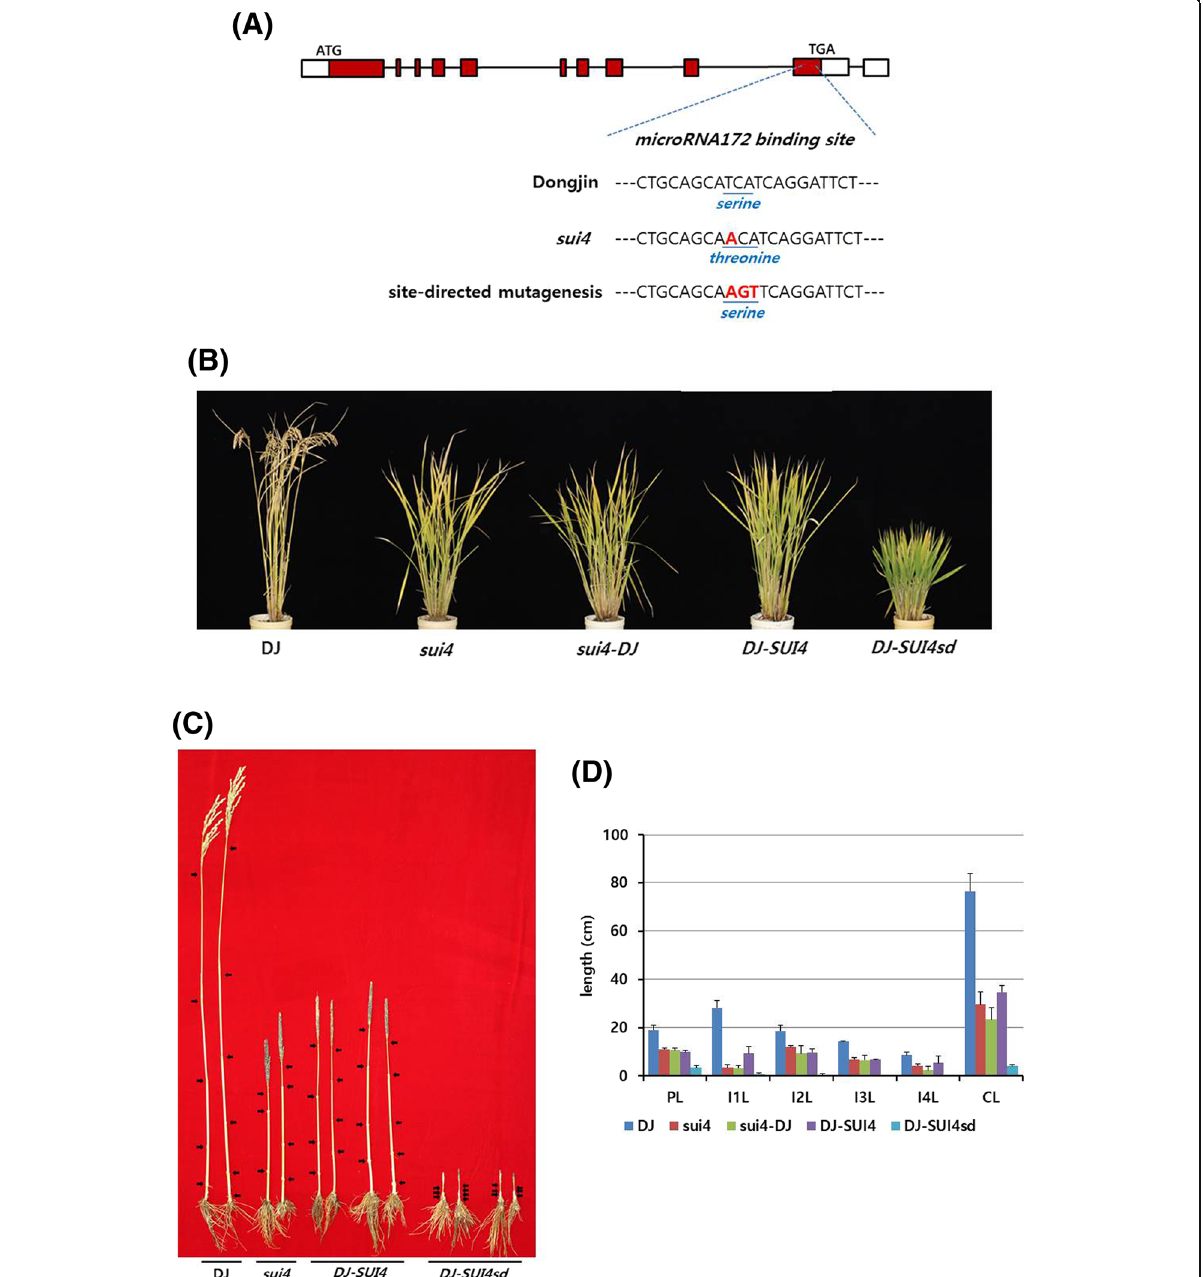
Fig. 4 Mutations in the Os07g0235800 gene and phenotypes of transgenic plants. ( a ) Structure of the SUI4/SNB gene and location of mutations. Empty boxes indicate 5 ′ and 3 ′ UTRs, filled boxes indicate CDS, and lines indicates introns. ( b ) Plant architecture at the maturing stage. DJ: Dongjin, sui4-DJ : transgenic line in which the SUI4 gene from a Dongjin plant was introduced into sui4 mutants, DJ-SUI4 : transgenic line in which the SUI4 gene from a sui4 mutant was introduced into Dongjin plants, DJ-SUI4sd : transgenic line in which the SUI4 gene, modified by site- directed mutagenesis as shown in ( a ), was introduced into Dongjin plants. ( c ) Culm structure. Arrows indicate locations of nodes. Two main culms from two plants are shown for each phenotype. Two independent transgenic lines are shown for DJ-SUI4 and DJ-SUI4sd. ( d ) Lengths of panicles, culms, and internodes. For DJ and sui4 , three main culms from three different plants were measured. For sui4 - DJ , DJ-SUI4 , and DJ-SUI4sd , six main culms from three to four independent transgenic lines were measured. PL: panicle length, I1L: first internode length, I2L: second internode length, I3L: third internode length, I4L: forth internode length, CL: culm